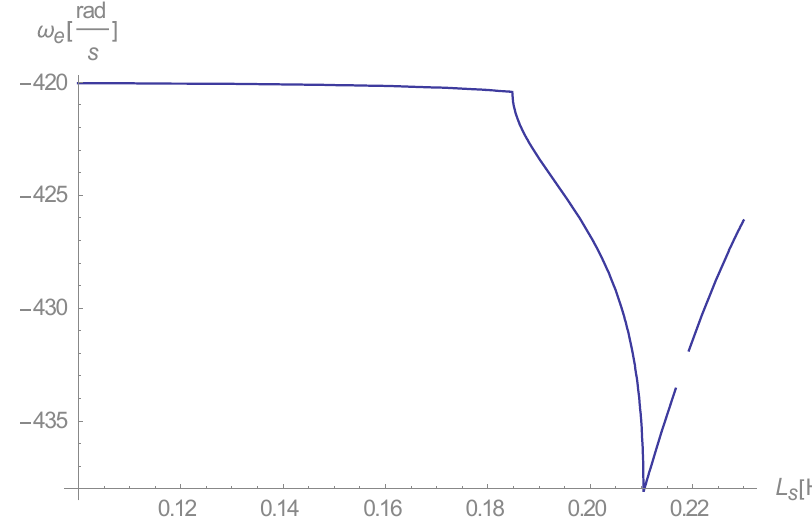
Figure 8. Plot of the real part of the third solution of ω (cid:2915) (L S ).